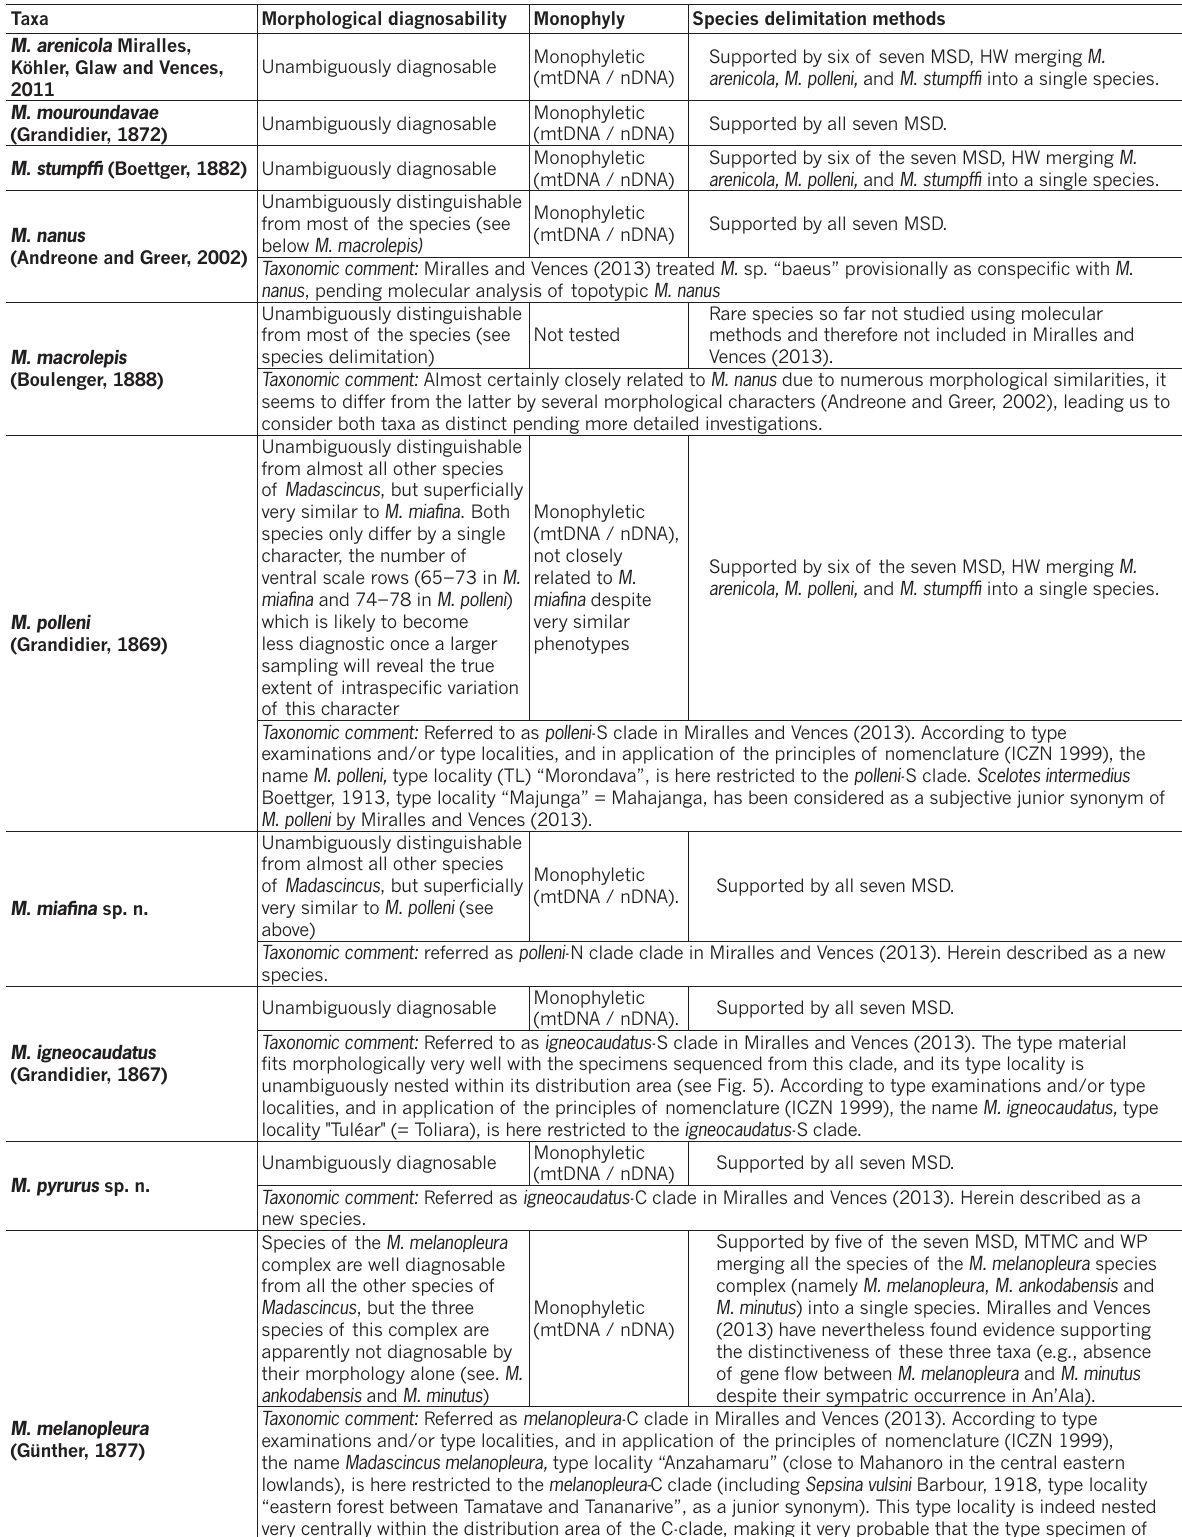
Table 4. List of the species presently recognized in the genus Madascincus , with the different lines of evidences supporting their distinctiveness. MSD = Methods of species